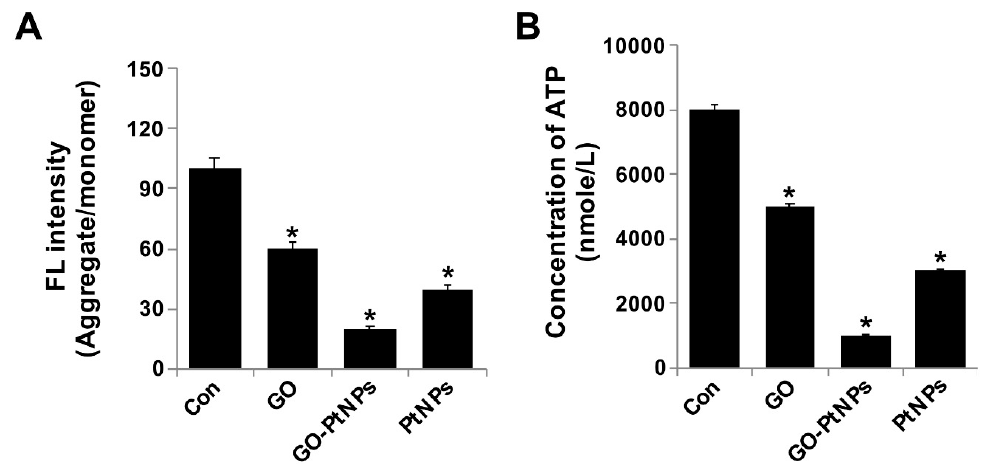
Figure 10. GO, GO-PtNPs, and PtNPs decrease mitochondrial membrane potential and ATP content. LNCaP cells were treated with respective IC50 concentration of GO, GO-PtNPs, and PtNPs for 24 h and spectrophotometric determination of JC-1 monomer/aggregate formation using cationic fluorescent indicator JC-1 ( A ). Intracellular ATP content ( B ). The treated groups showed